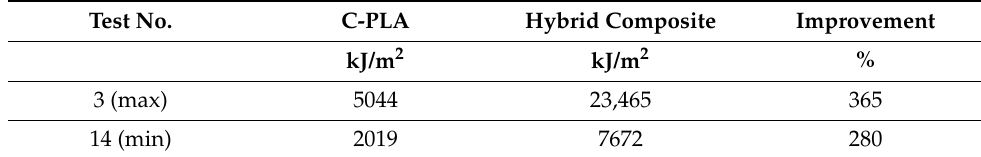
Table 4. Improvement by laying ABS on C-PLA